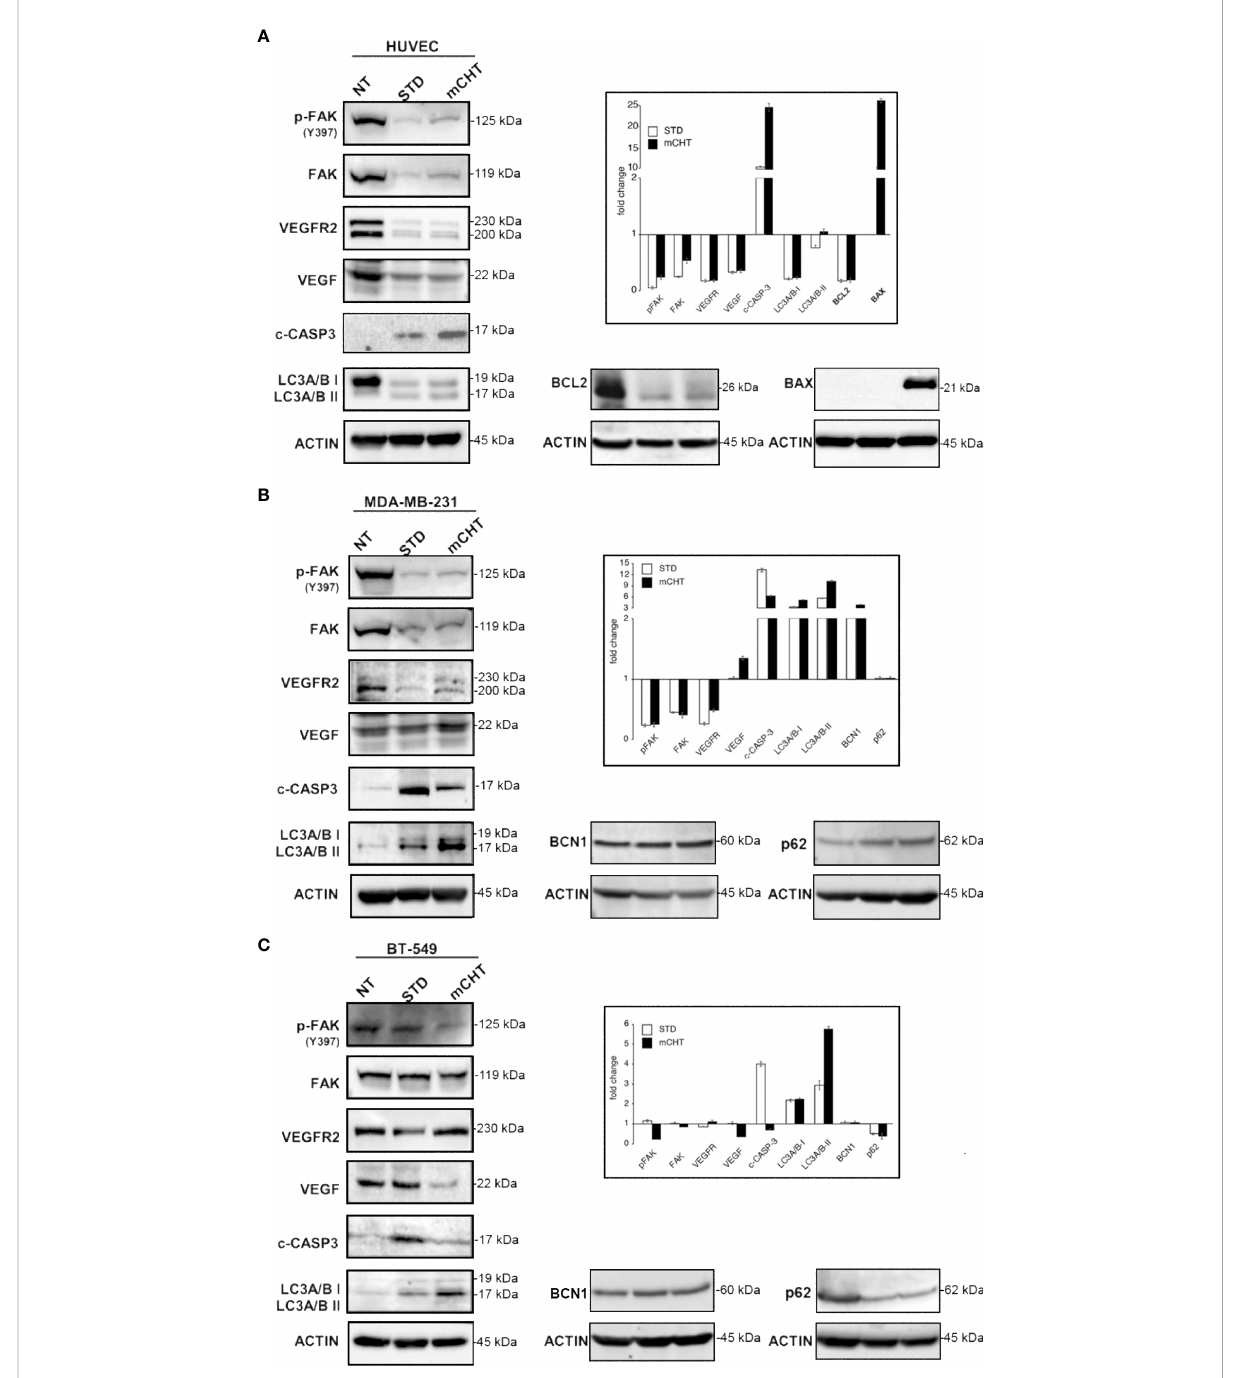
FIGURE 7 Metronomic and standard treatment with 5-FU+VNR differently affect pathways involved in migration, angiogenesis, apoptosis and autophagy in HUVECs and TNBC cells. Representative western blots of HUVECs, MDA-MB-231 and BT-549 treated with STD or mCHT 5-FU +VNR. In the insets: protein expression levels as calculated by densitometry of the western blot results. Quanti fi cation of protein expression levels was normalized to the loading control actin and compared to the untreated control set as 1. Values represent the average ± SD of three independent